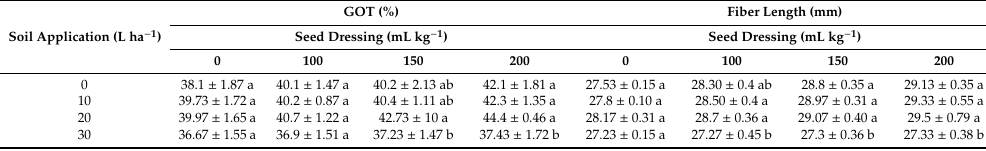
Table 3. The e ff ect of the soil applied and seed dressed potassium humate on the ginning out turn (GOT) and fiber